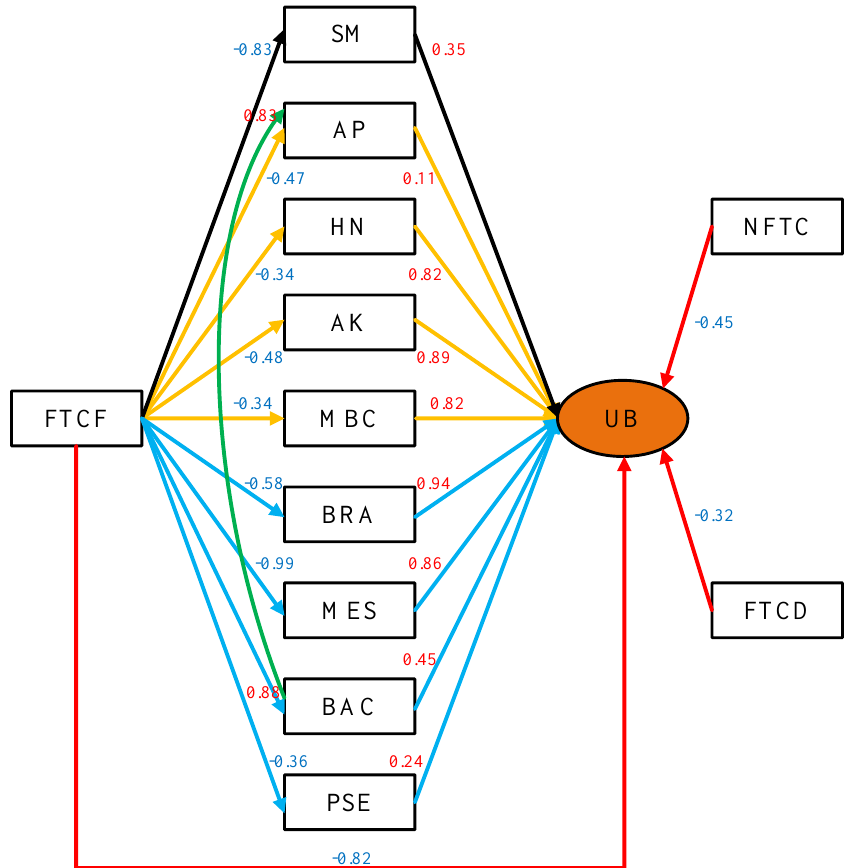
Figure 7. Short-term correlation analysis, UB is underground biomass, AP is available phosphorus, HN is hydrolyzable nitrogen, AK is available K, MBC is microbial biomass carbon, NFTC is the number of freezing – thawing cycles, FTCD is the number of freezing – thawing cycle days, FTCF is the freezing-thawing cycle frequency, BRA is Bradyrhizobium , MES is Mesorhizobium , BAC is Bacillus , PSE is Pseudomonas , and SM is soil moisture. The colors of the arrows correspond to the colors of the lines in Figure 1. The same color indicates the same direction, blue words indicate a negative correlation, red words indicate a positive correlation, and the above correlation coefficients were all found to be statistically significant at the P = 0.05 level.